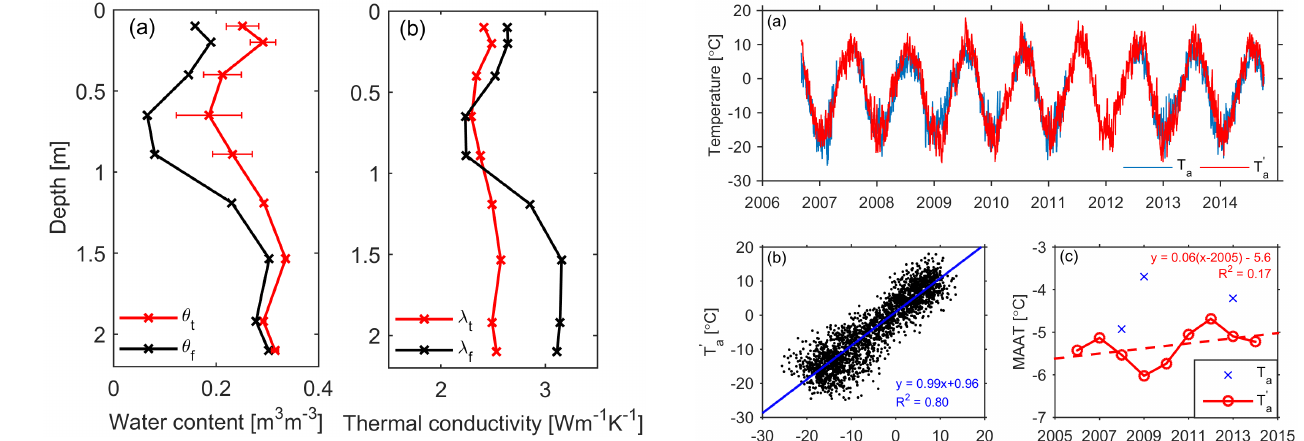
Figure 6. Seasonal change in soil water content (a) and thermal conductivity (b) calculated with Eq. (1) in the thick active layer in 2008. θ t and θ f are the mean total water content during the sum- mer period and winter period, respectively, and λ t and λ f are the corresponding thermal conductivities. Table 3. Interannual variation of the maximum seasonal thermal conductivity ratio ( λ t /λ f ) in the monitoring profile. ∗ Hydrological year occurs from 1 May to 30 April.